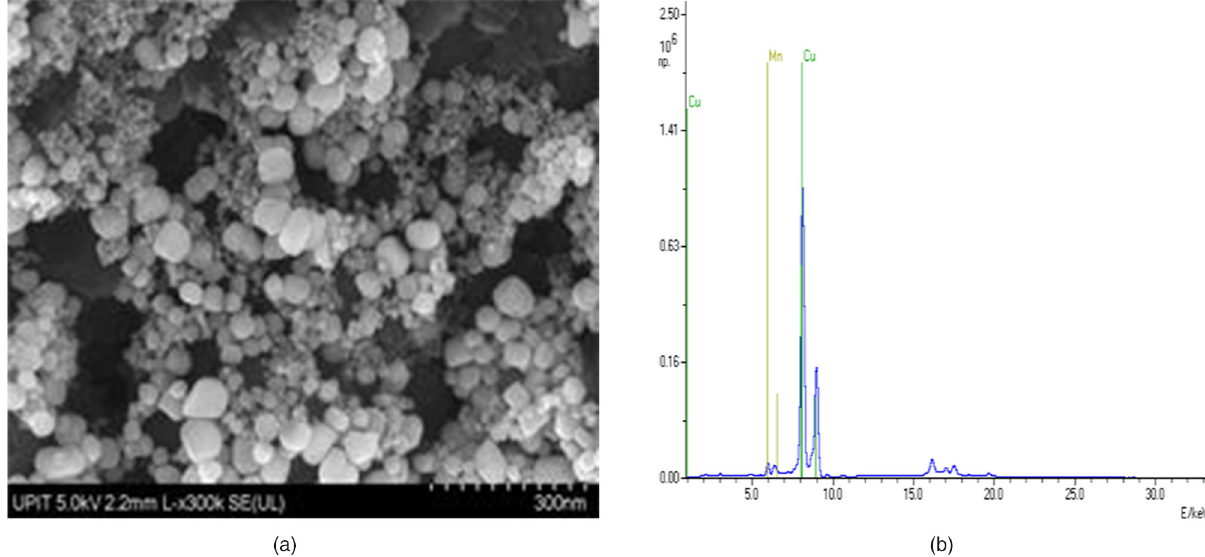
Fig. 4. (a) SEM micrograph of nano-SPVD powders of CuO doped with Mn. (b) EDX spectrum of nano-SPVD powders of CuO doped with